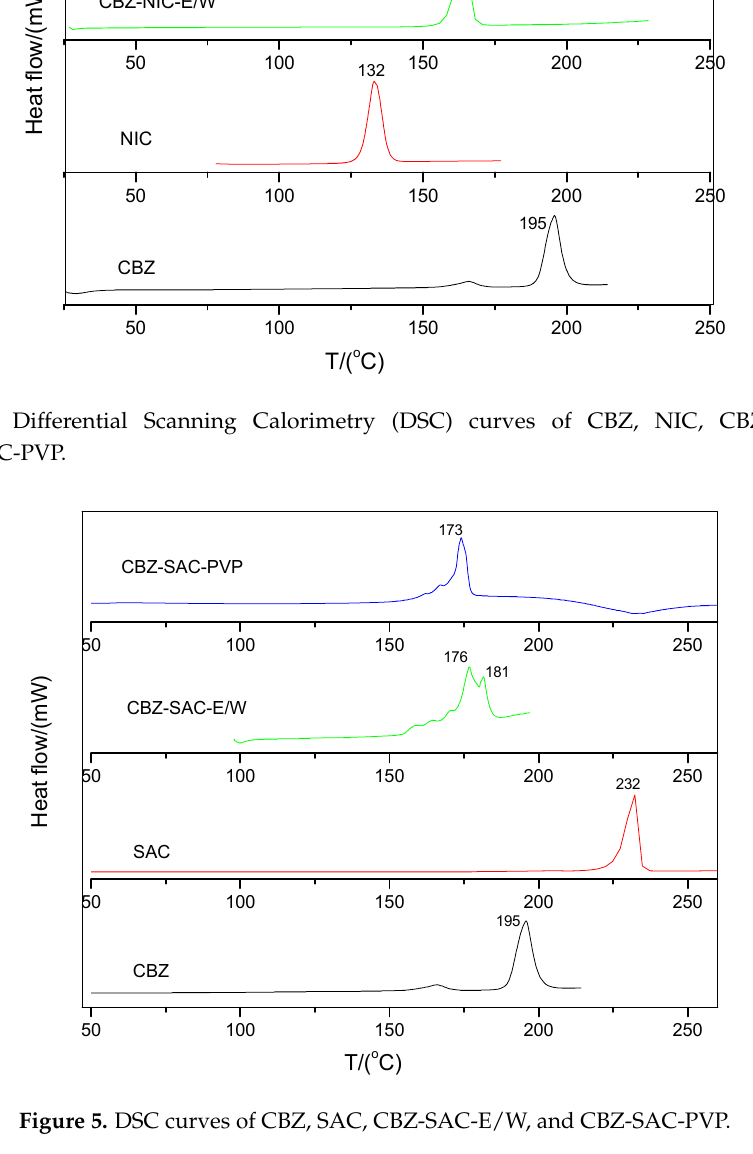
Figure 5. DSC curves of CBZ, SAC, CBZ-SAC-E/W, and CBZ-SAC-PVP.